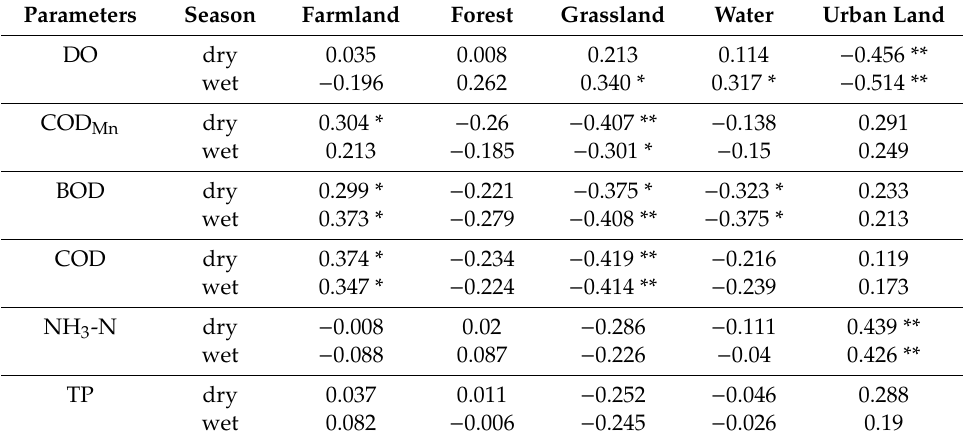
Table 4. Pearson correlation coe ffi cients between land use types and water quality. Parameters Season Farmland Forest